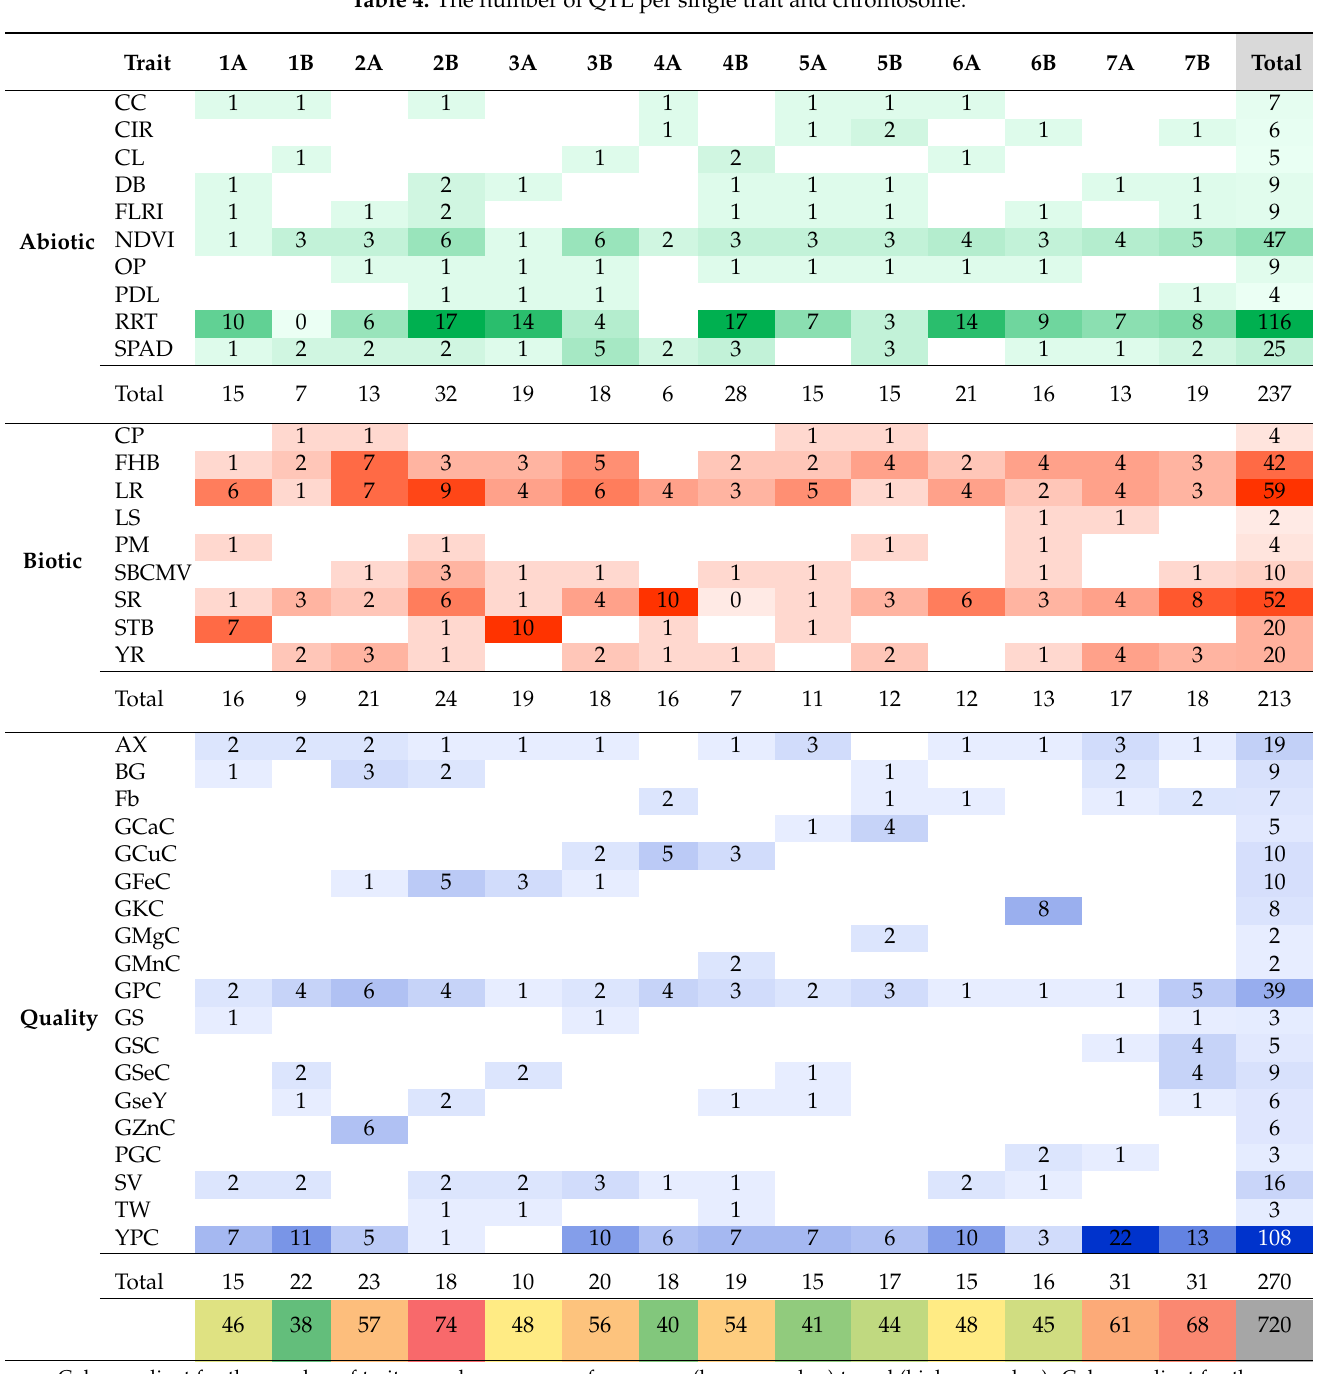
Color gradient for the number of traits per chromosomes: from green (lower number) to red (higher number). Color gradient for the number of QTL per trait: low intensity (lower number) to high intensity (higher number). Abiotic stress (green): CC: Chlorophyll content; CIR: carbon isotope ratio; CL: coleoptile length; DB: dry biomass; FLRI: plag leaf rolling index; NDVI: normalized difference vegetation index; OP: osmotic potential; PDL: length of the ear peduncle; RRT: root-related trait; SPAD: Chlorophyll concentration measure. Biotic stress (red): CP: Claviceps purpurea ; FHB: Fusarium head blight; LR: leaf rust; LS: loose smut; PM: powdery mildew; SBCMV: soil-borne cereal mosaic virus; SR: stem rust; STB: Septoria tritici blotch; YR: yellow rust. Quality (blue): AX: Arabinoxylan; BG: β -glucan; Fb: flour yellow color; GCaC: grain calcium concentration; GCdC: grain cadmium concentration; GCuC: grain copper concentration; GFeC: grain iron concentration; GKC: grain potassium concentration; GMgC: grain magnesium concentration; GMnC: grain manganese concentration; GPC: grain protein content; GS: gluten strength; GSC: grain sulfur concentration; GSeC: grain selenium concentration; GSeY: grain selenium yield; GZnC: grain zinc concentration; PGC: phosphorus grain concentration; SV: SDS-sedimentation volume; TW: test weight; YPC: yellow pigment